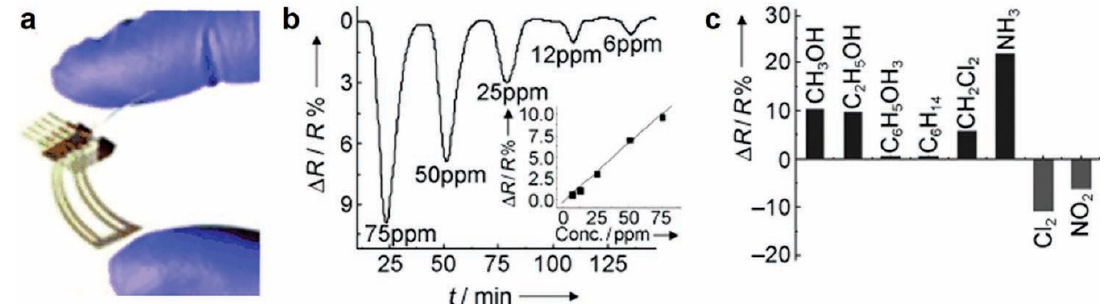
Figure 1. Flexisense, inkjet-printed graphene oxide and reduced graphene oxide for gas and vapor concentration detection [38]. ( a ) All-organic rGO-based flexible chemiresistor; ( b ) Resistance change versus time plot when the sensor was exposed to Cl 2 vapor; ( c ) Change in resistance with exposed to other vapor; Reproduced with permission from John Wiley and Sons